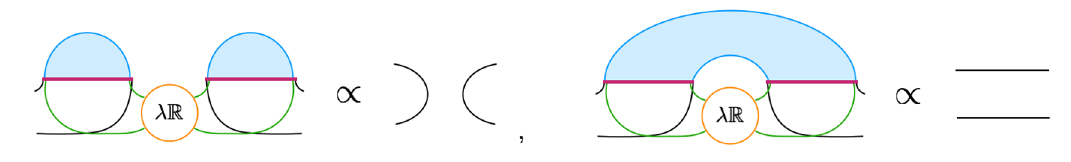
Figure 6 . Example geometries that give rise to the projector or the identity. All possible contri- butions are either proportional to the identity operator 1 R | (cid:15) R i h (cid:15) R | 1 ,R 2 1 ,R 2